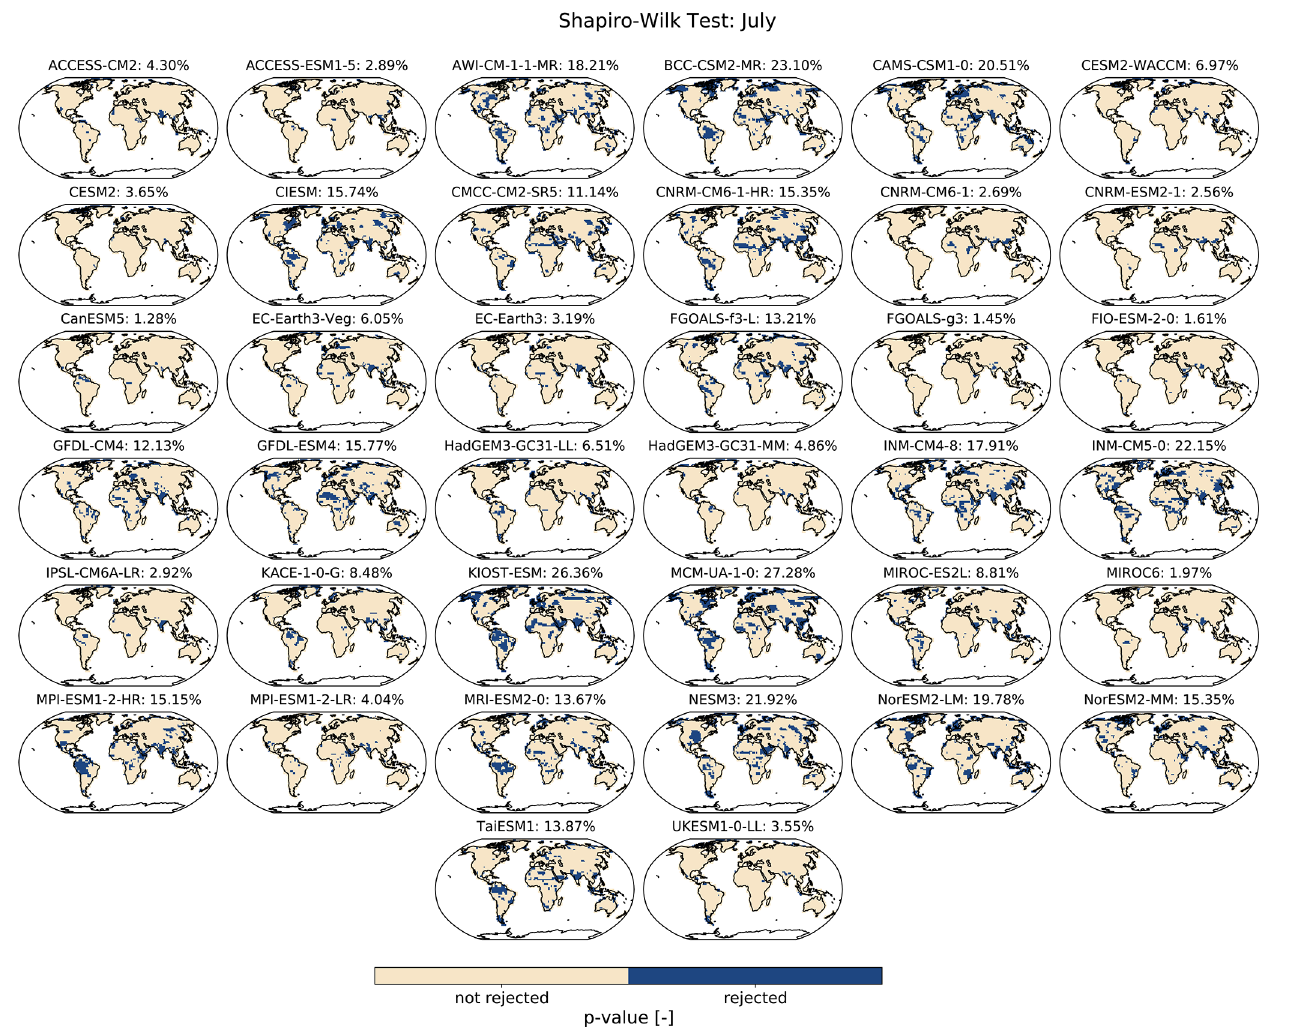
Figure B2. Same as Fig. B1, except for